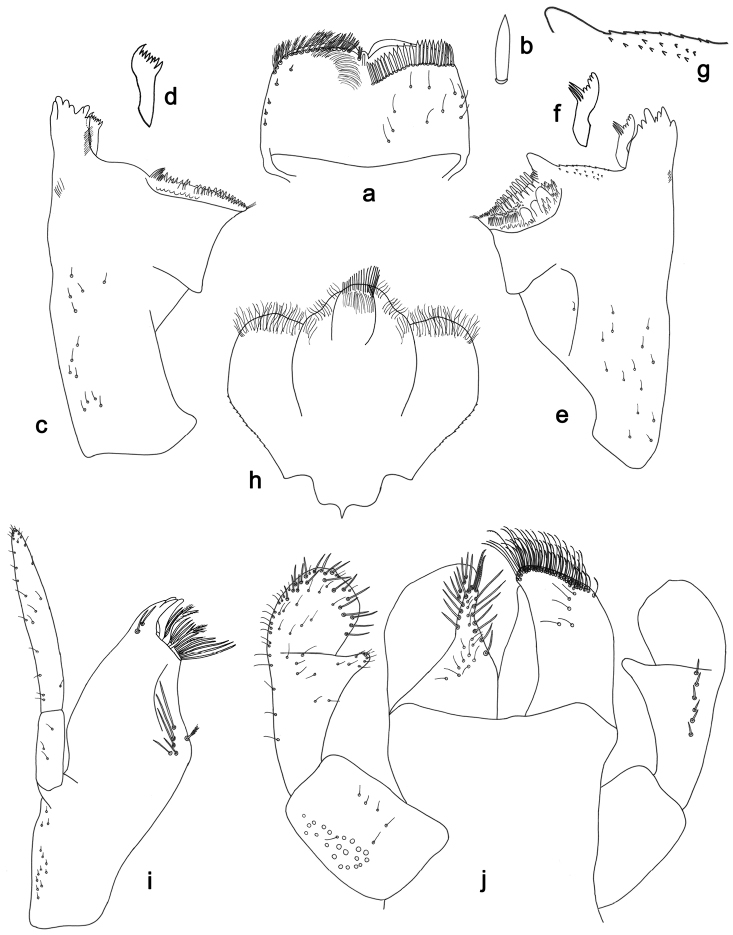
Labiobaetisvallus sp. n., larva morphology: a Labrum b Labrum dorsal, submarginal seta c Right mandible d Right prostheca e Left mandible f Left prostheca g Left mandible, area between prostheca and mola hHypopharynxi Maxilla j Labium.